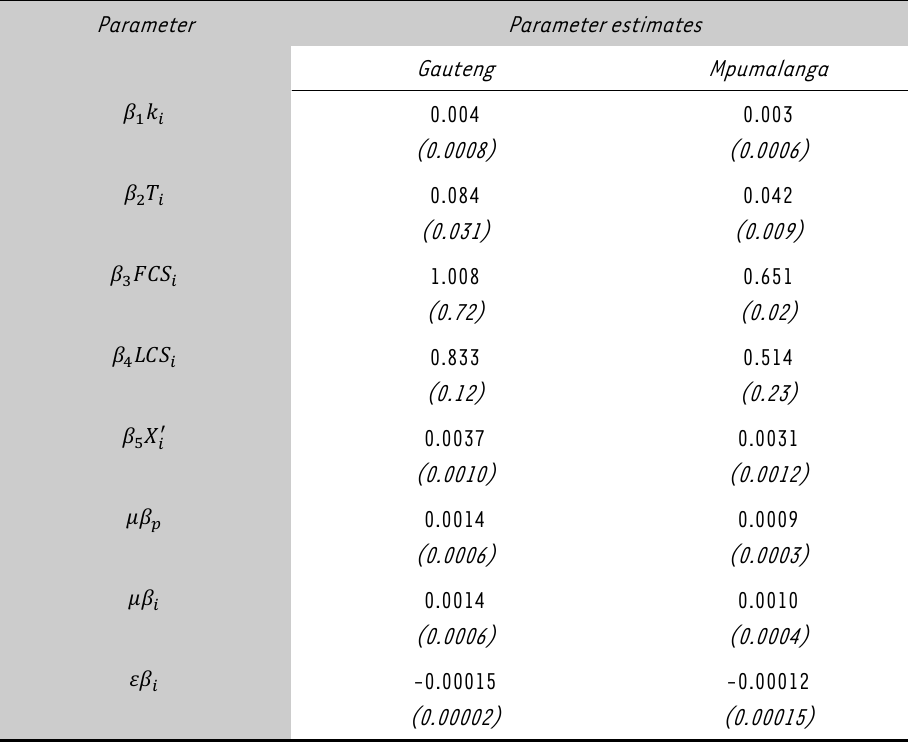
TABLE 2: Parameter estimates for the wage function of the category B employee segment Parameter Parameter estimates